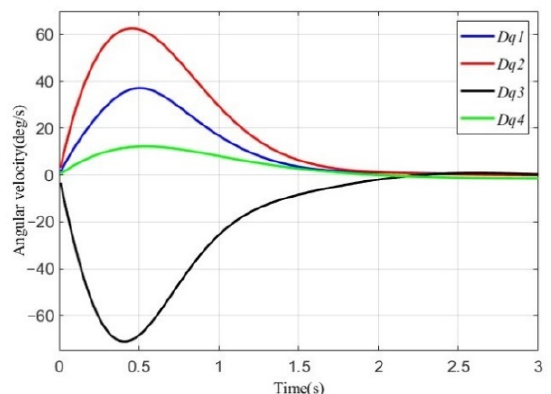
Figure 12. Angular velocities under the action of controller.